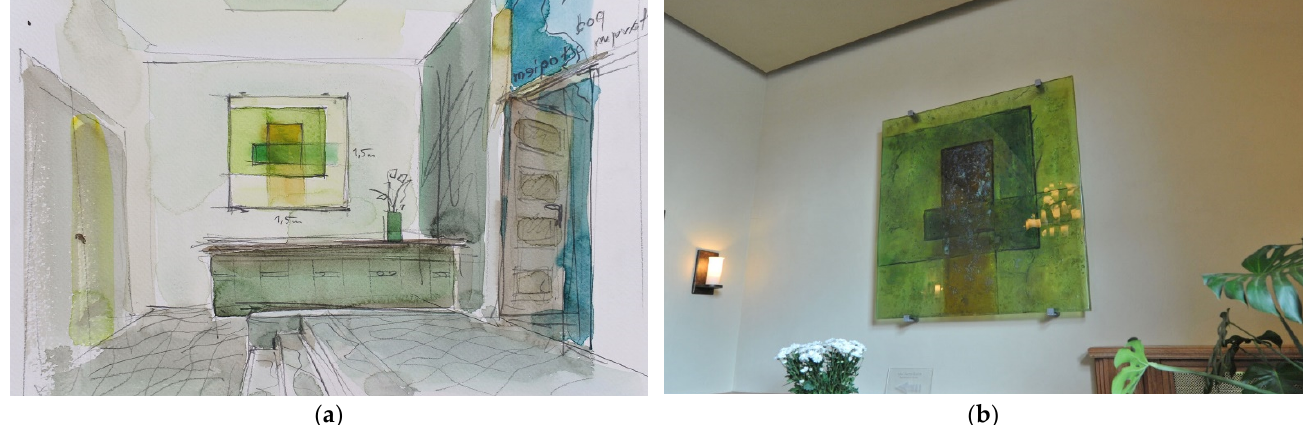
Figure 9. Architectural glass art composition by Tomasz Urbanowicz in the entry hall of the town hall in Głogów, Poland, 2009: ( a ) watercolor design; ( b ) final glass element (Tomasz Urbanowicz).